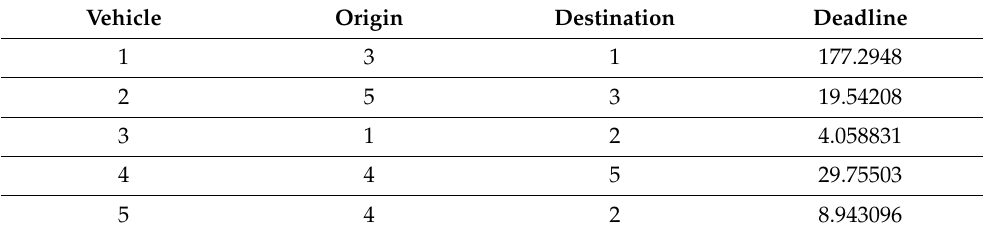
Table A2. The origin, destination, and deadline of vehicles (5 nodes and 5 vehicles example).